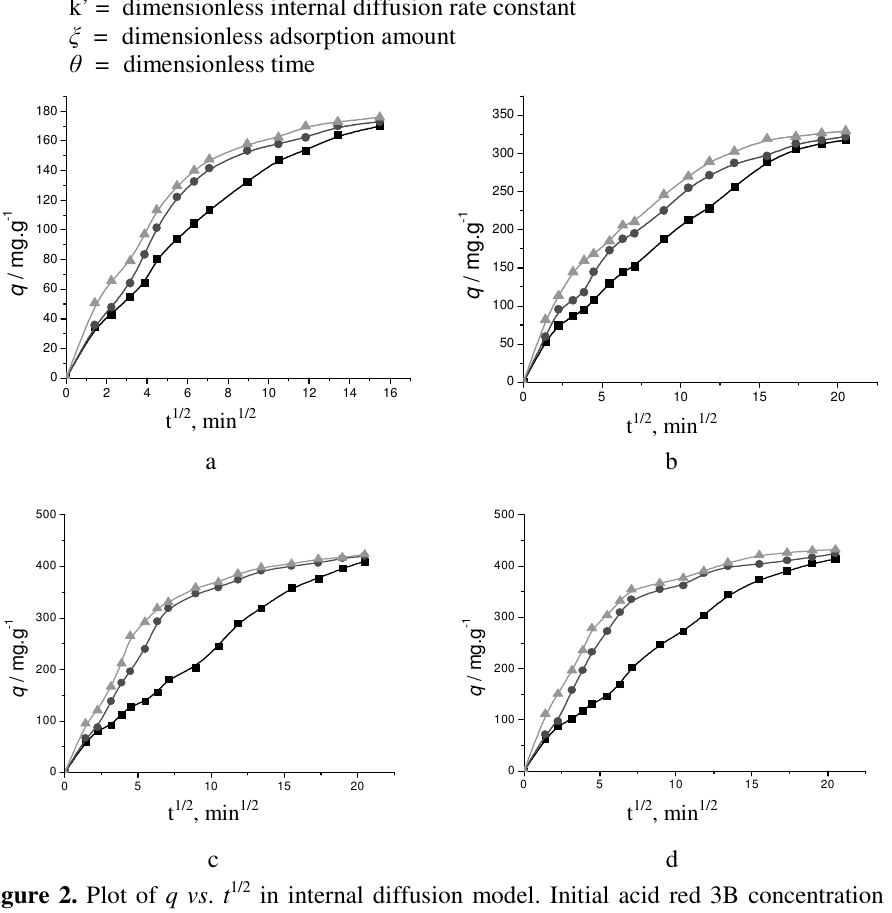
Figure 2. Plot of q vs . t 1/2 in internal diffusion model. Initial acid red 3B concentration is (a) 200 mg/L, (b) 400 mg/L, (C) 600 mg/L, (d) 400 mg/L; ( ■ ) 5°C ( ● ) 25°C ( ▲ )